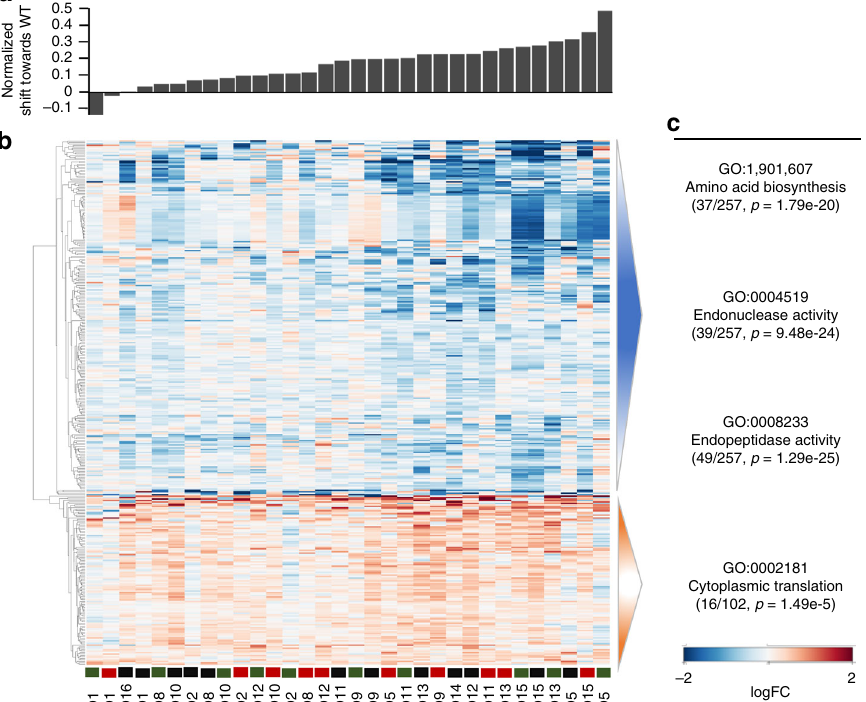
Fig. 8 Changes of gene expression pattern associated with attenuation towards WT. a Evolved disomic strains, sorted by the normalized expression shift towards WT (see “ Methods ” ). b Heat map of 359 genes whose expression correlates with the shift across evolved strains. Evolved lines of each disomic strains are shown in green (evolved line 1), red (evolved line 2) and black (evolved line 3). The list of genes with log2-fold changes along with adjusted p -values ( t -test) can be found in Supplementary Data 5. c Enriched GO terms for genes. In parenthesis, the fi rst number corresponds to the total number of genes in this GO category, and the second number indicates the total number of up-regulated or down-regulated genes. Enrichment adjusted p -values for each GO category are also